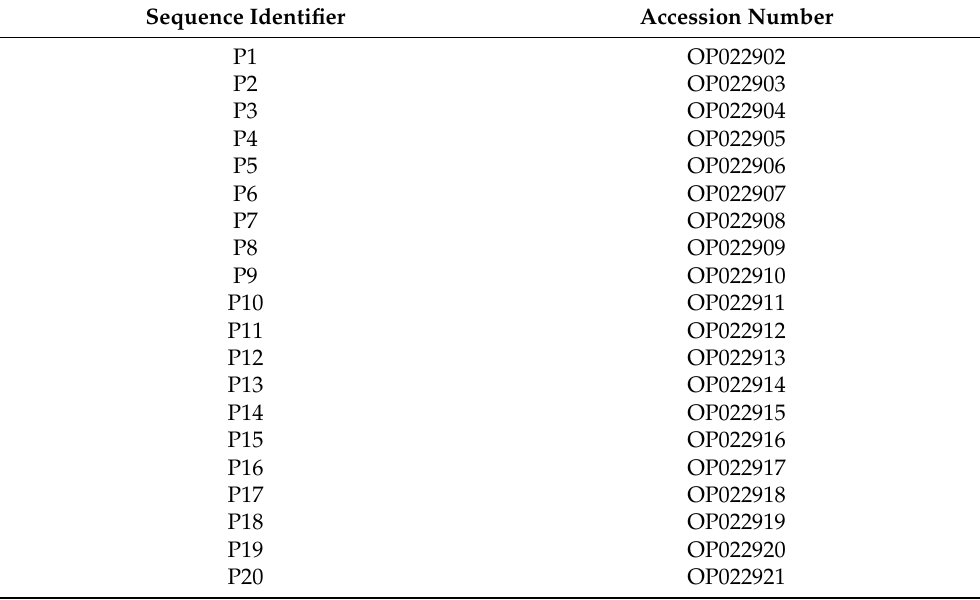
Table A1. Table of accession numbers assigned to whole HCV genome sequences submitted to GenBank